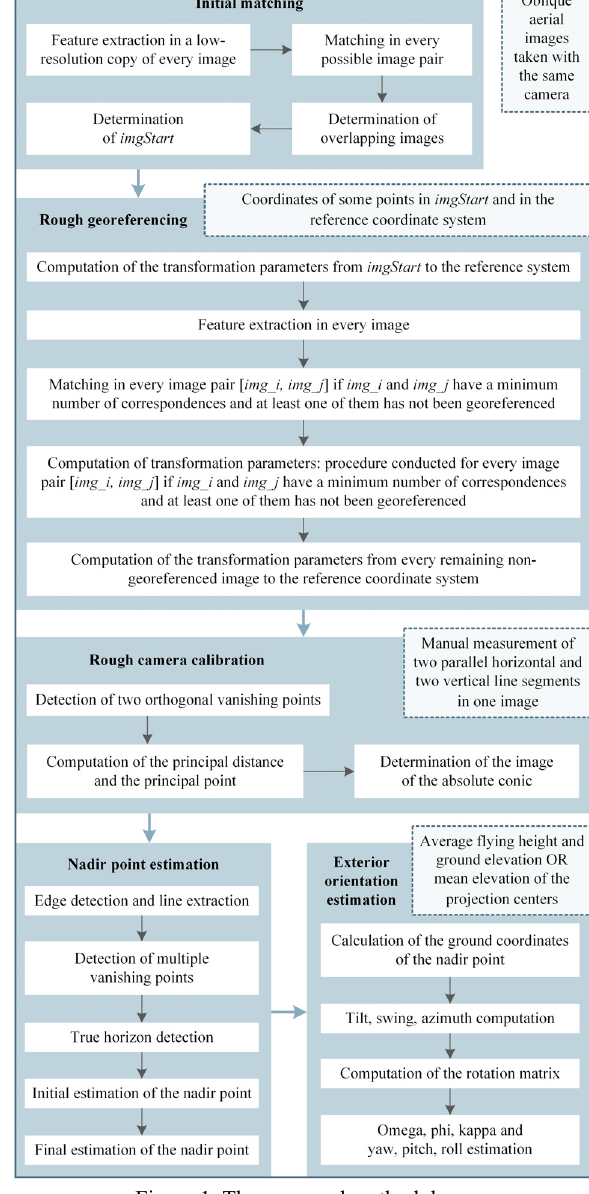
Figure 1. The proposed